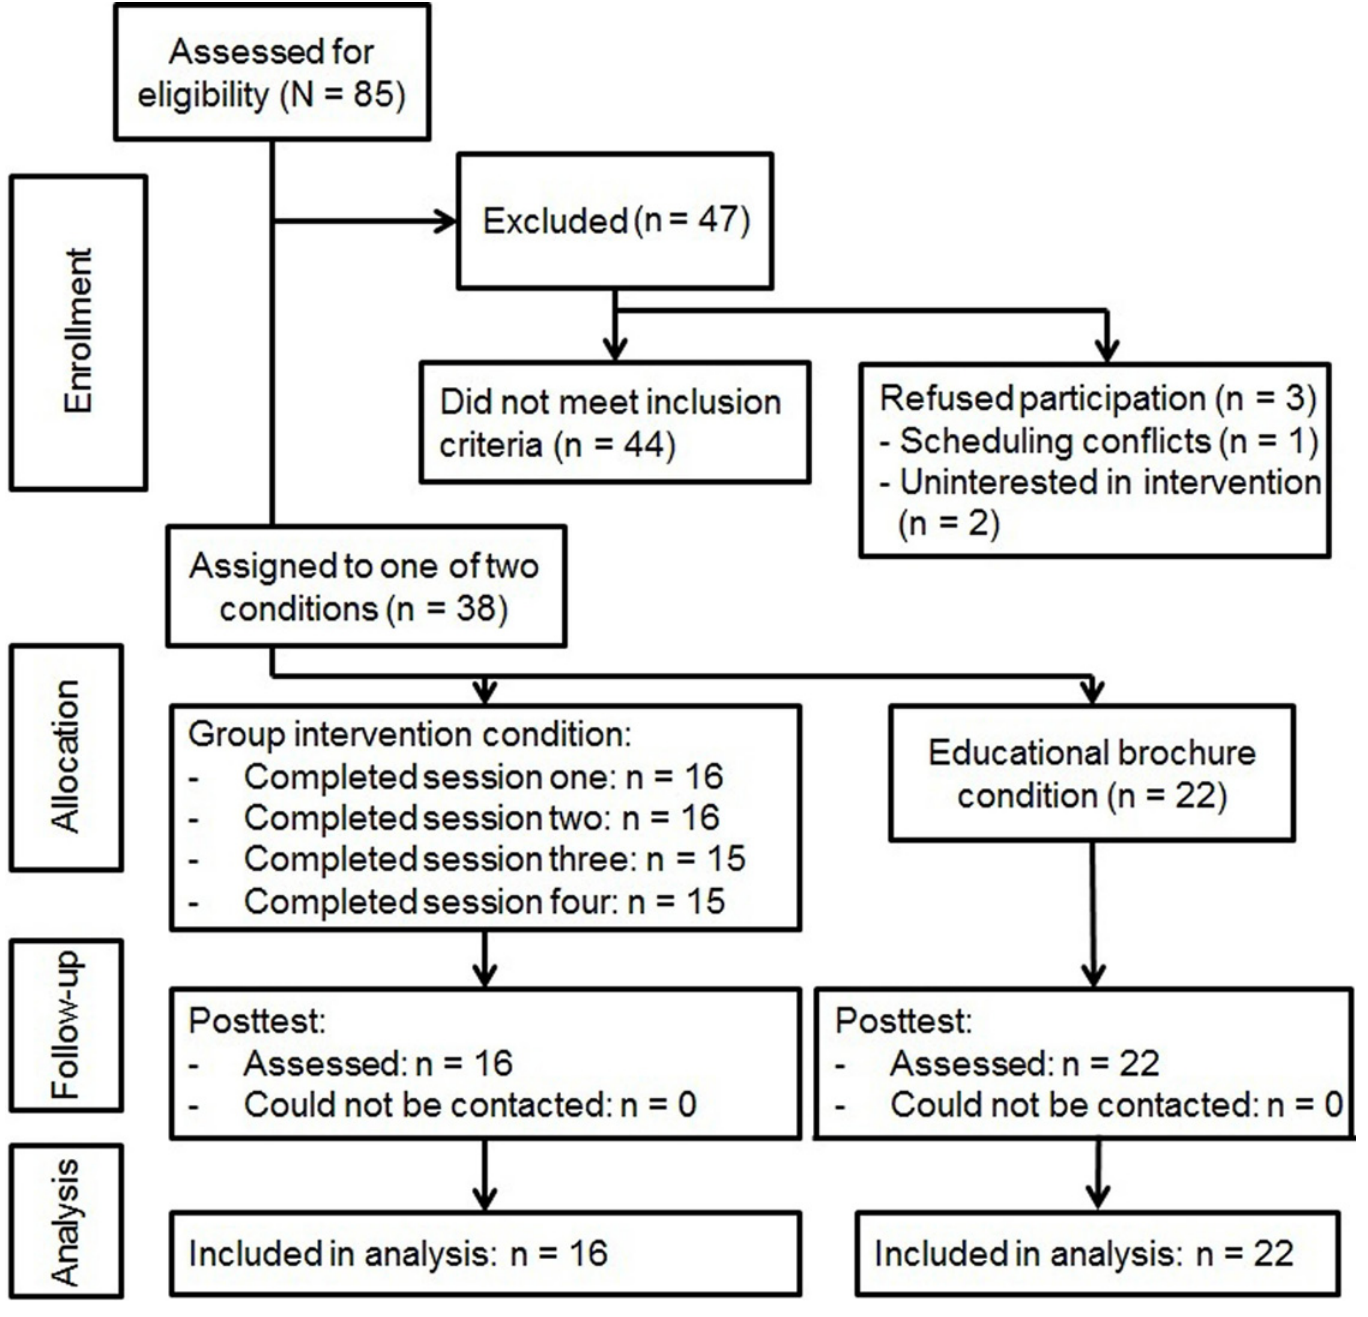
Fig 2. Participant Flow